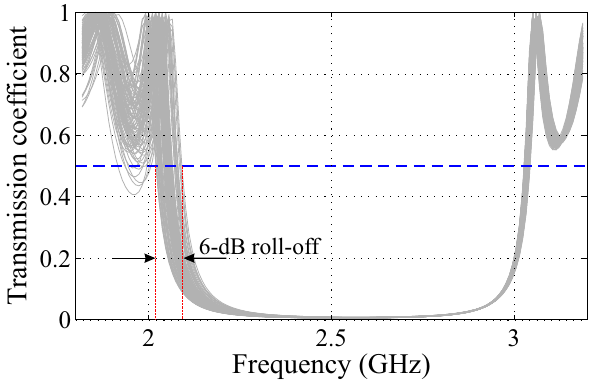
Figure 8: Uncertainty in the 6-dB roll-off frequency ( 100 MC curves are depicted).